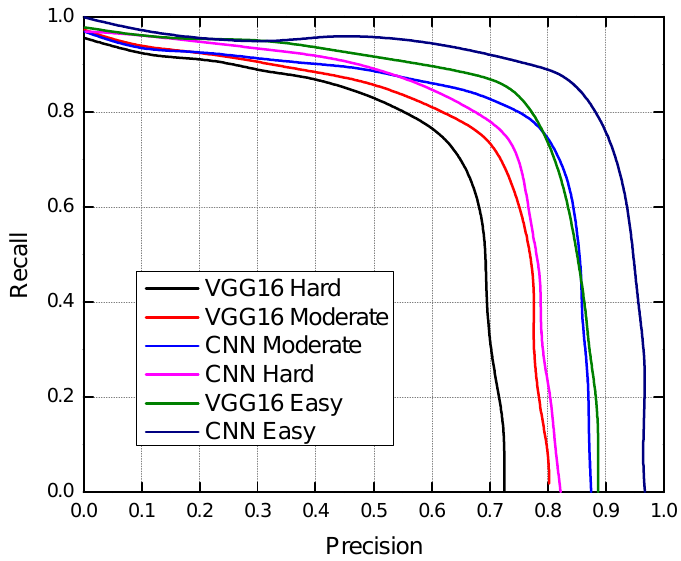
Figure 6. Three object classes with three varying degrees of complexity were examined using our CNN model, the VGG16 model, and its Precision–Recall